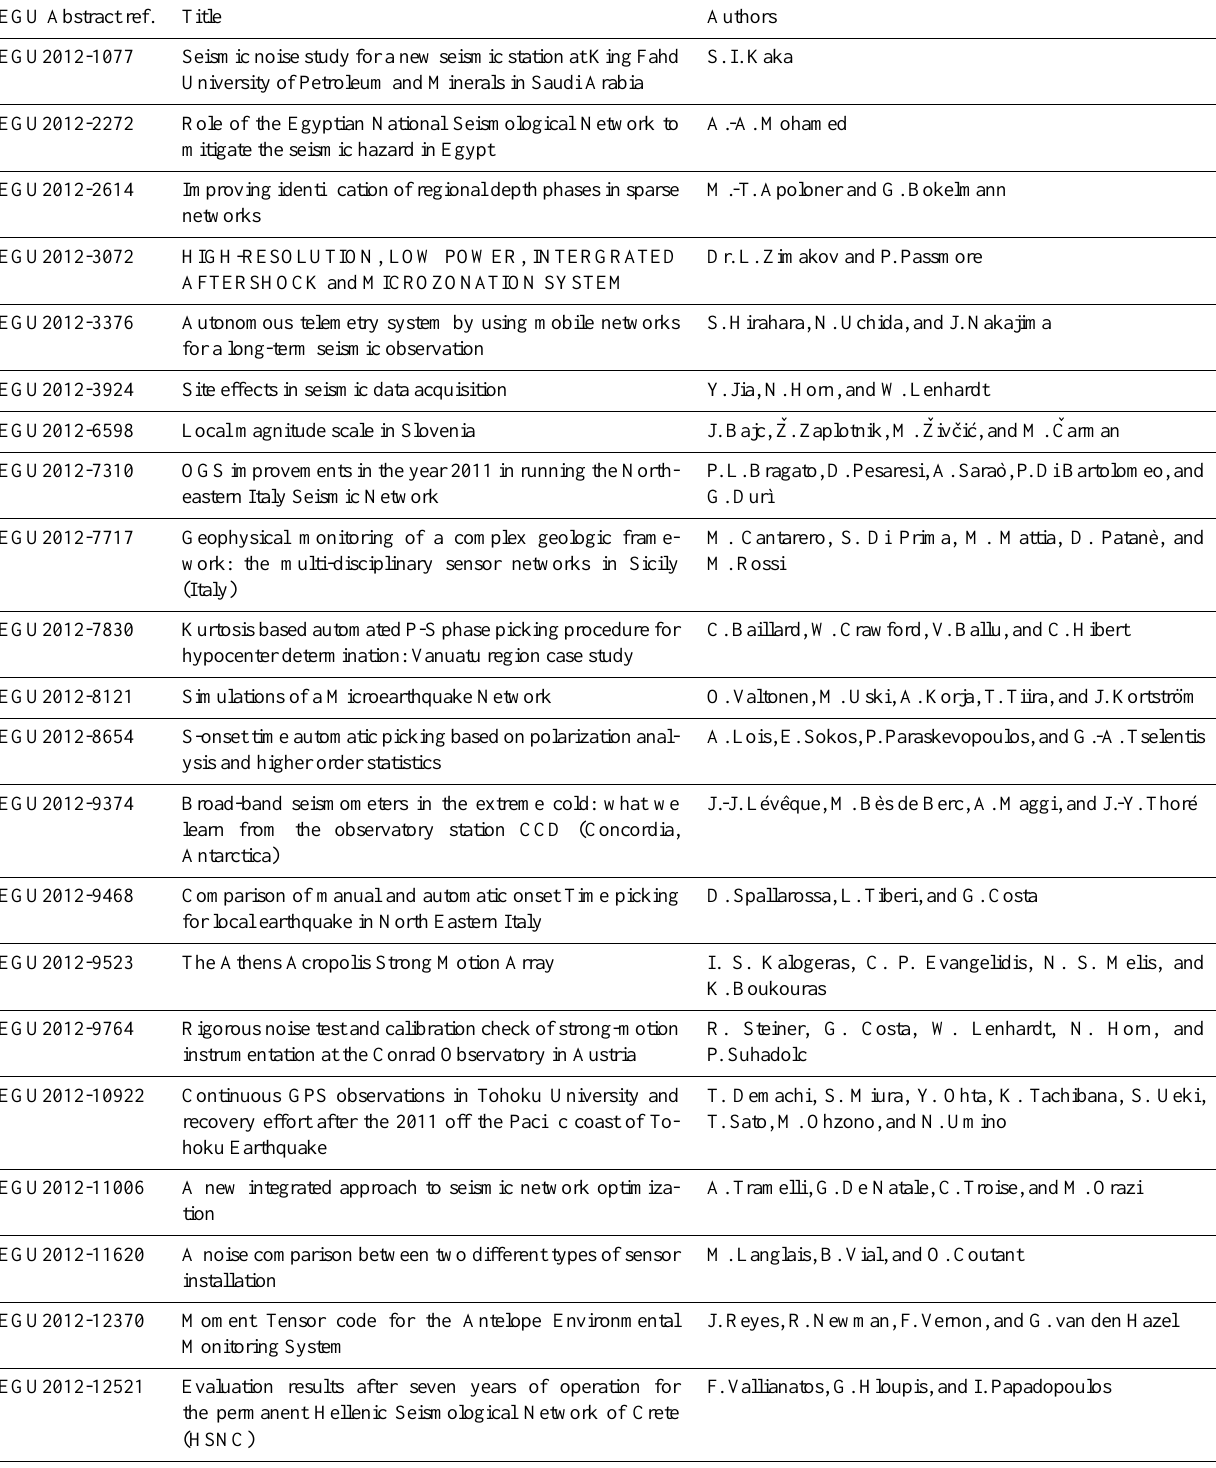
Table 2. Poster Programme